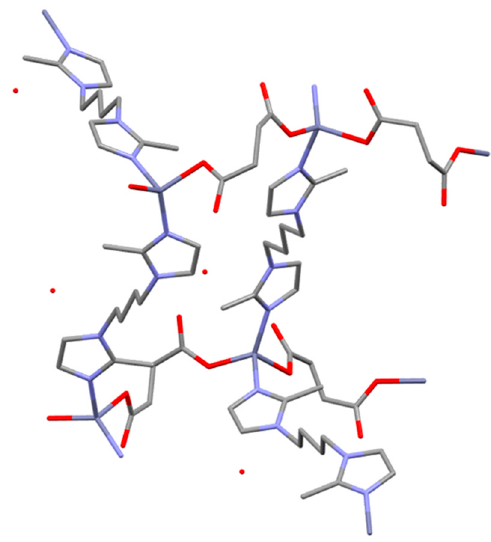
Figure 6. The network of the complex {[Zn(bib)(fu)]·CH 3 OH} n [104] . (Zn, N, O).